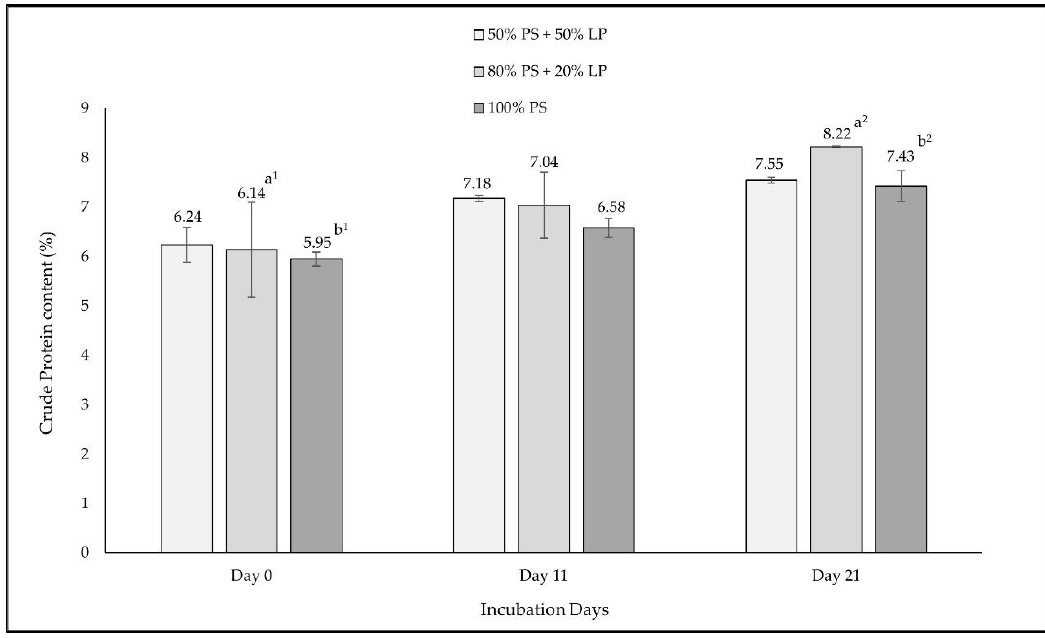
Figure 2. Evaluation of crude protein content (%) for PS and its mixtures with OMSW. Statistical analysis was performed for each substrate individually between Day 0 and Day 21. Different superscripts between the same letters indicate statistical significance ( p ≤ 0.05).